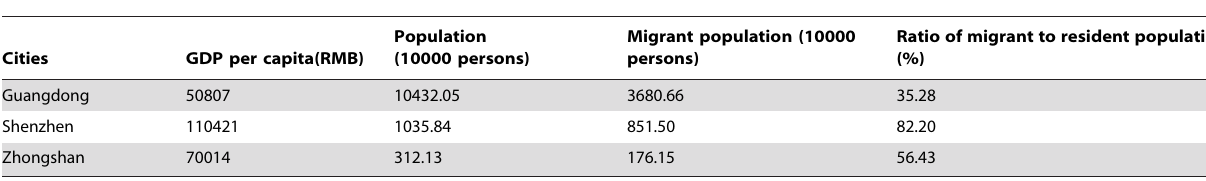
Table 1. General information of study cities (2011).